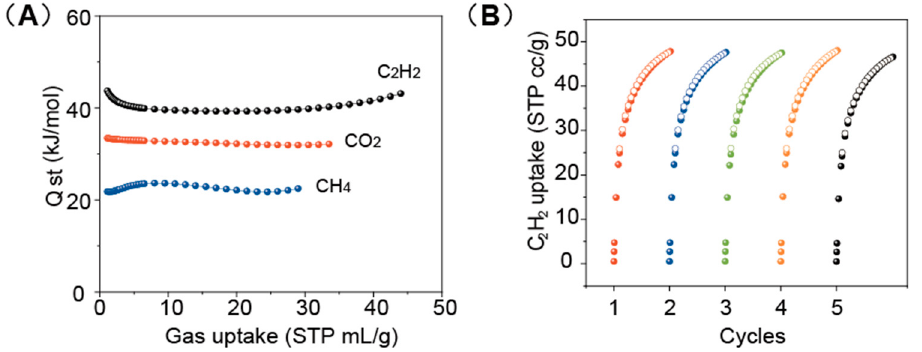
Figure 4. ( A ) Q st for C 2 H 2 , CO 2 and CH 4 in 1 . ( B ) Cycling adsorption ‐ desorption experiments. Before every measurement, 1 was regenerated at 200 (1st), 150 (2nd), 100 (3rd) 50 (4th), 25 (5th) °C, respectively, for 30 min.